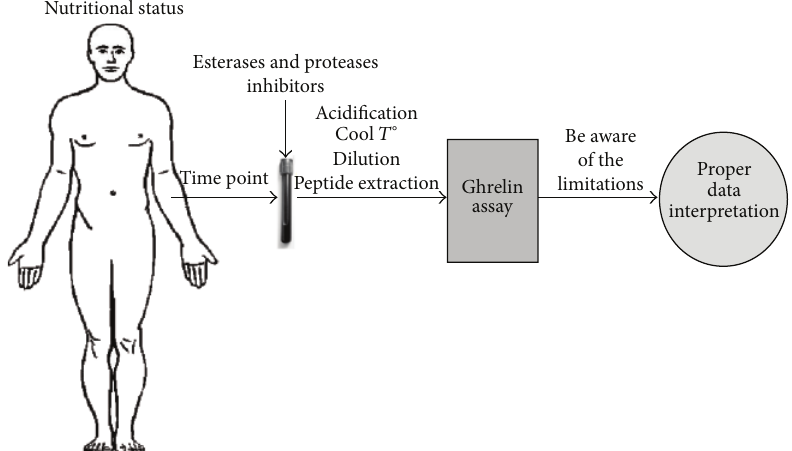
Figure 4: Proposed controlled steps necessary to allow accurate ghrelin levels determination. 𝑇 ∘ : temperature.